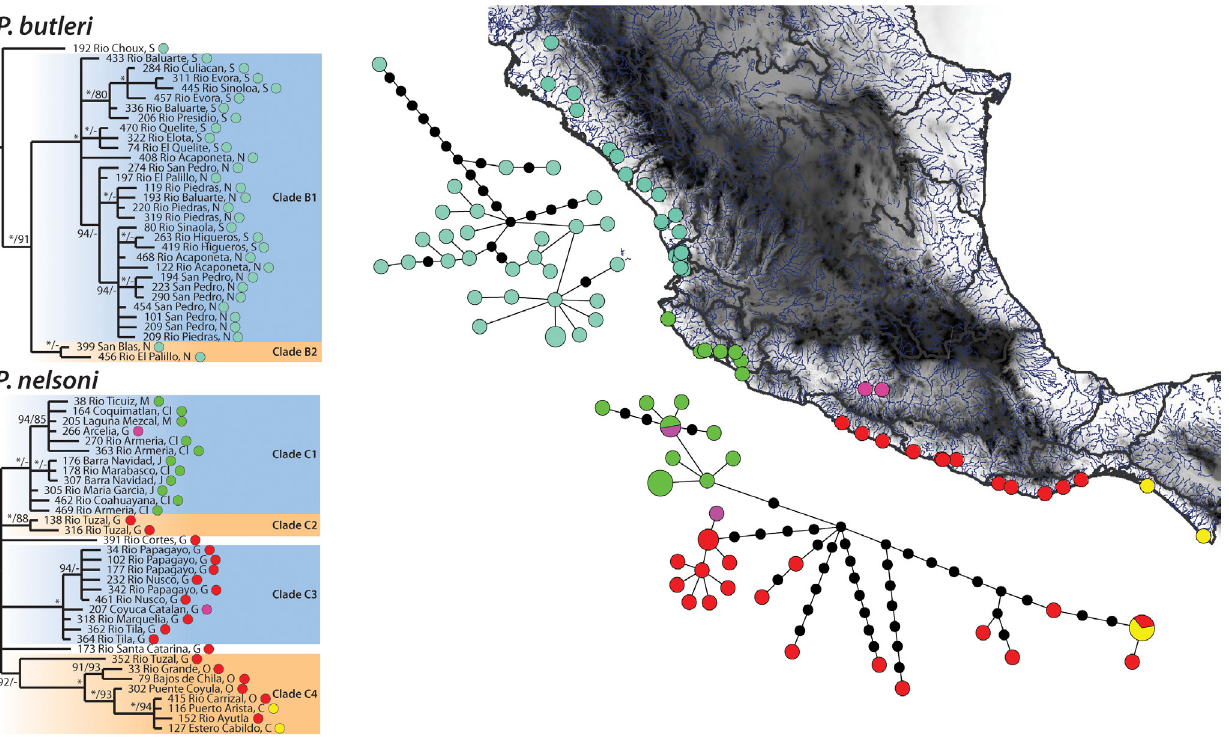
FIGURE 4 | Cytochrome b (1,140 bp) mitochondrial gene Bayesian phylogeny, parsimony haplotype network, and sampling distribution of the Pacific sister taxa Poecilia butleri (blue-North of the Trans Mexican Volcanic Belt) and P. nelsoni (lime green-South of the Trans Mexican Volcanic Belt, pink- Balsas River Drainage, red- North of the Isthmus of Tehuantepec, and yellow- South of the Trans Mexican Volcanic Belt) across geographic barriers along the coast of Mexico. The phylogeny has Bayesian posterior values followed by bootstrap values with asterisks representing support of 95% or above. The Parsimony network values correspond to the haplotype values and are colored according by geographic locations separated by barriers; circle sizes correspond to the number of individuals with that haplotype (larger circles reflect more individuals), and black cirles indicate unsampled haplotypes. The capital letters at the end of each sample represents the state of origin in Mexico, from North to South: S = Sinaloa, N = Nayarit, J = Jalisco, Cl = Colima, M = Michoacan, G = Guerrero, O = Oaxaca, C =